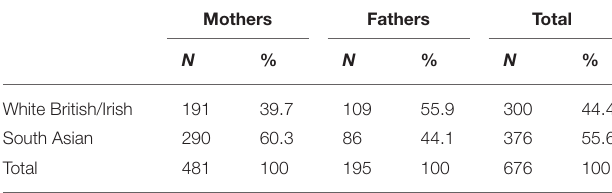
TABLE 1 | Description of Tower Hamlets sample by ethnicity and parent